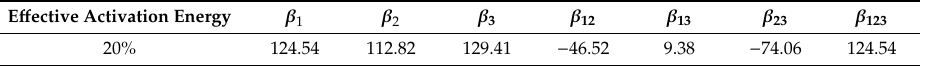
Table 8. Coe ffi cients of activation energy mixture design for Si-Fe-Ni.